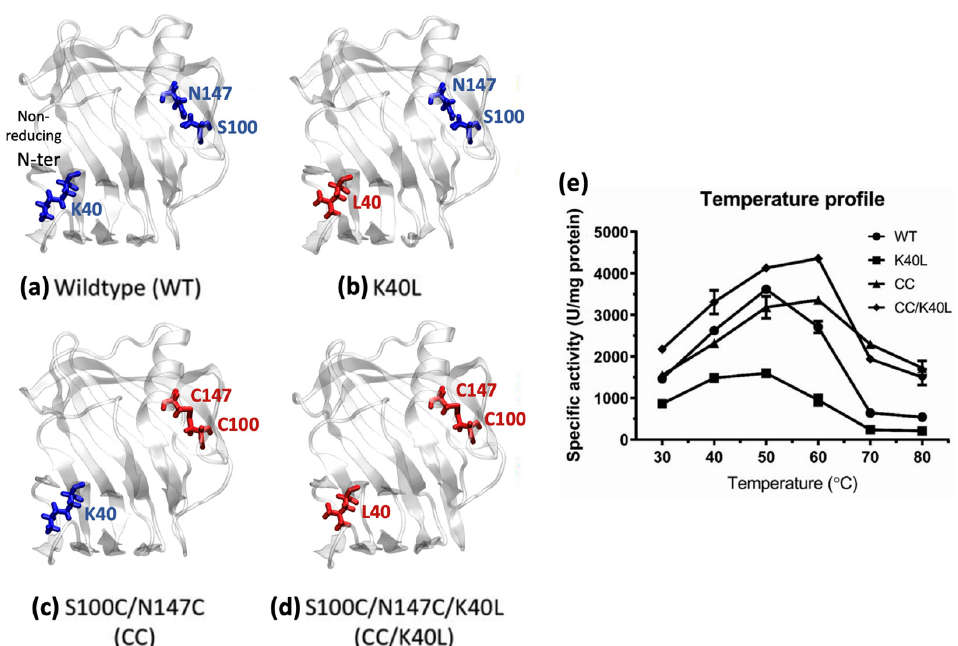
Figure 1. Three-dimensional structures of the recombinant xyn11A from Bacillus firmus K-1 and its mutants designed by Boonyaputtikul et al. [17] ( a ) wildtype (WT), ( b ) K40L, ( c ) S100C/N147C or CC, and ( d ) S100C/N147C/K40L (CC/K40L). Unmutated amino acid residues at positions 40, 100, and 147 were shown in blue, while the mutated residues were shown in red. ( e ) Temperature profiles of specific activity of enzymes in ( a – d ) measured by the Nelson-Somogyi method.